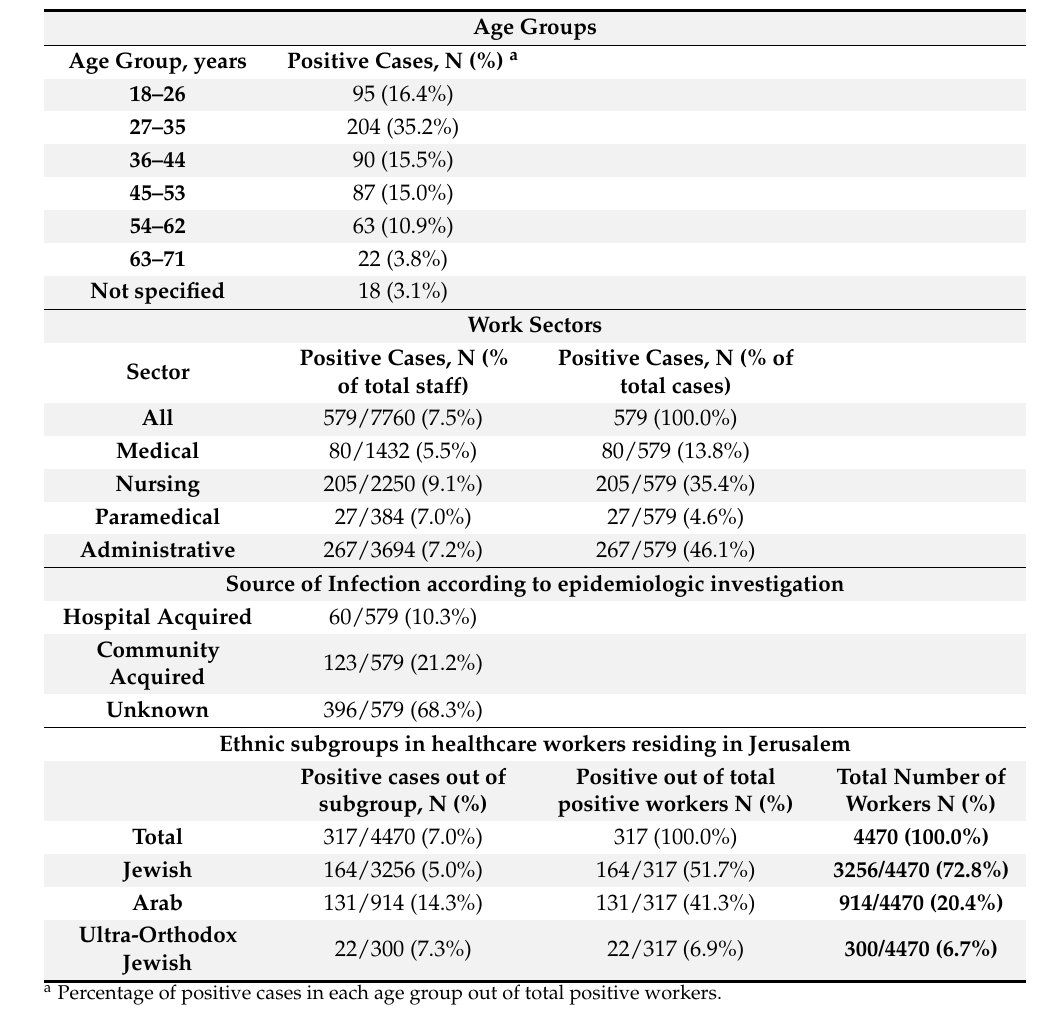
Table 1. Demographic characteristics of SARS-CoV-2-positive healthcare workers, March–December 2020 (n =